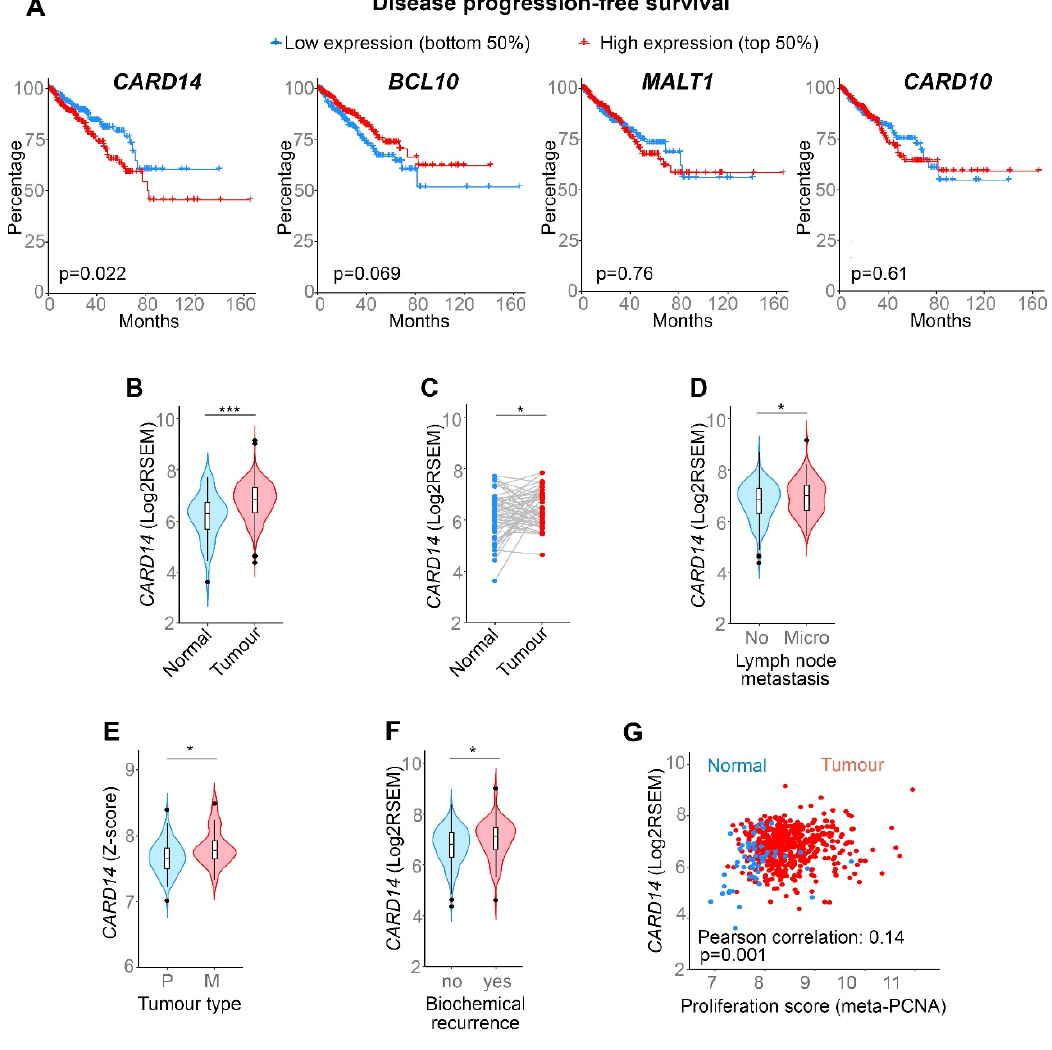
Figure 1. High CARD14 expression correlates with aggressive cancer in human PCa patients. ( A ) Kaplan–Meier curve of the probability of disease-free survival for PCa patients with low or high CARD14 , CARD10 , MALT1 , or BCL10 RNA level, based on the TCGA RNAseq dataset. p value generated by the Log-rank test is indicated. ( B , C ) CARD14 expression in normal and tumour (paired ( C )) PCa tissue, based on TCGA data. ( D – F ) CARD14 expression as a function of lymph node metastasis ( D ) (no: no presence of metastasis in lymph nodes; micro: presence of microme- tastasis in lymph nodes); tumour metastasis ( E ) (P: primary tumour, M: metastatic tumour) or bi- ochemical recurrence ( F ) for PCa, based on TCGA data ( D , F ) or MSKCC data ( E ). p value generated by the Welsh t -test is indicated as * p < 0.05, *** p < 0.001. ( G ) CARD14 mRNA expression as a func- tion of proliferation score.